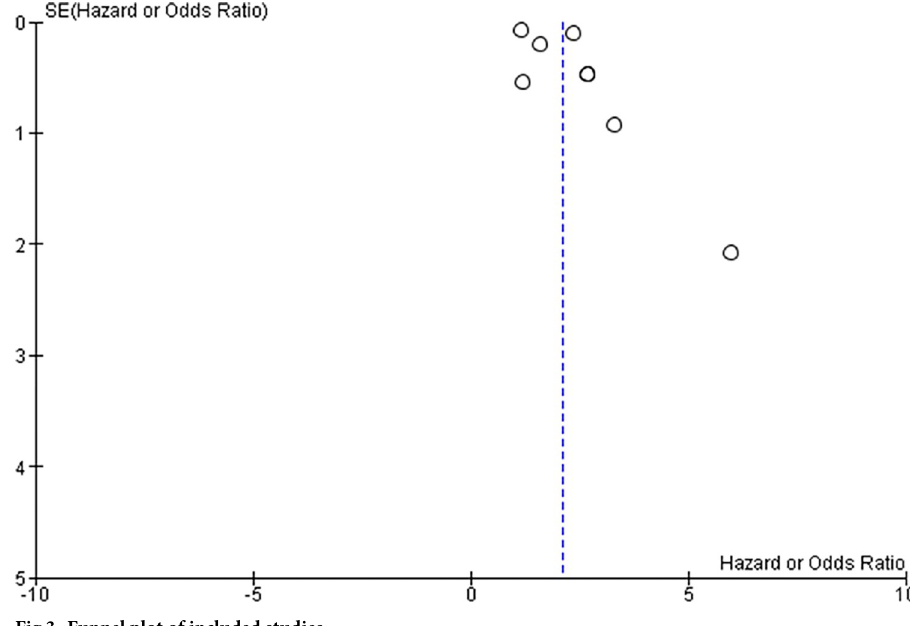
Fig 3. Funnel plot of included